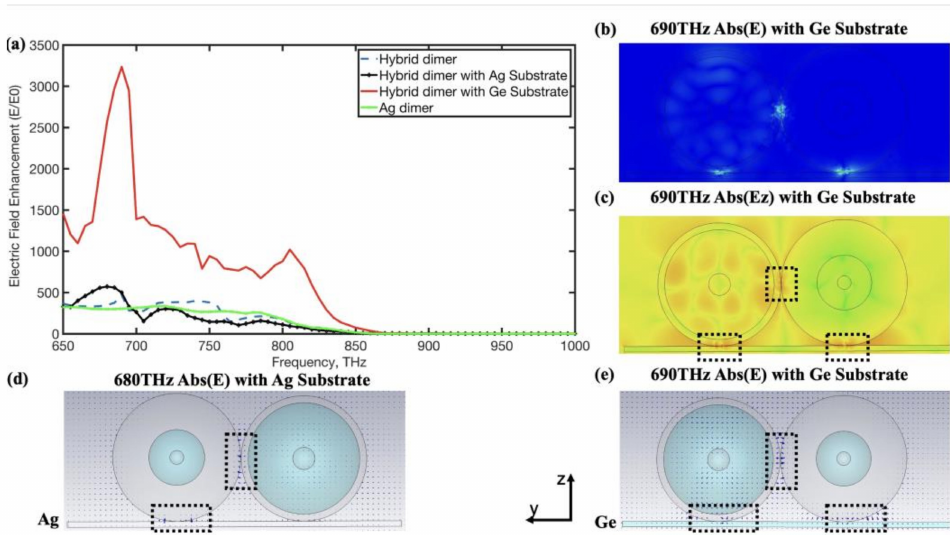
Figure 5. ( a ) The electric near-field enhancement of the hybrid dimer and Ag dimer without substrate and hybrid dimer with Ag/Ge substrate; ( b , c , e ) distribution of the absolute value of the hybrid dimer with Ge substrate electric field at the frequency 690 THz, and ( d ) the electric field of the hybrid dimer with Ag substrate at 680